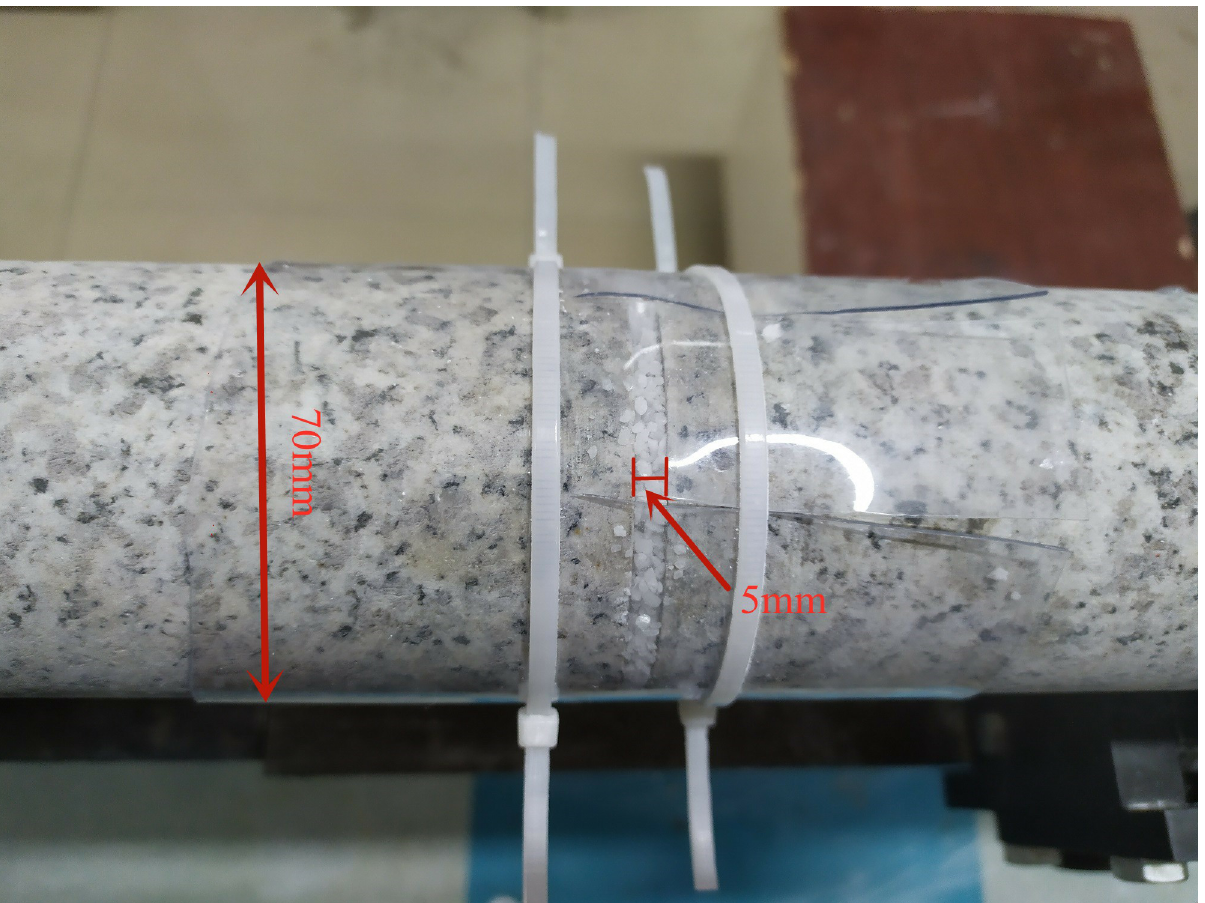
Fig 7. Filling material between the incident and transmitted rock bar.